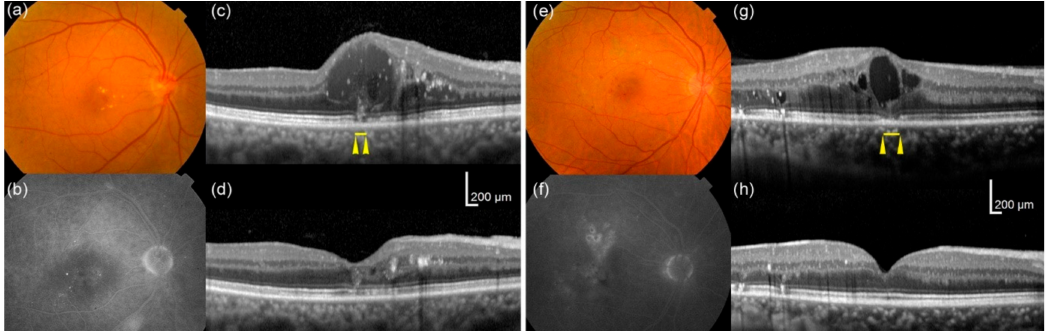
Figure 3. Representative cases with or without a high area ratio and large number of cystoid spaces at baseline. ( a – d ) A 74-year-old man whose eye had a high area ratio (38.6%) and a large number of intraretinal cystoid spaces at baseline exhibited a poor visual outcome; the best-corrected visual acuity (BCVA) was 0.222 at baseline and 0.301 at 12 months (both in LogMAR), while the extents of ELM (0 µ m) and EZ (271 µ m) disruptions were relatively small at baseline. ( e – h ) A 64-year-old man whose eye had a low area ratio (12.9%) and a small number of intraretinal cystoid spaces at baseline exhibited a good visual outcome; BCVA was 0.301 at baseline and − 0.079 at 12 months (both in LogMAR). In this eye, the extents of ELM (60 µ m) and EZ (220 µ m) disruptions were also relatively small at baseline. Fundus color photographs ( a , e ), fluorescein angiograms of late phase ( b , f ), and optical coherence tomography (OCT) images at baseline ( c , g ) and at 12 months ( d , h ). Arrowheads ( c , g ) show the extents of EZ